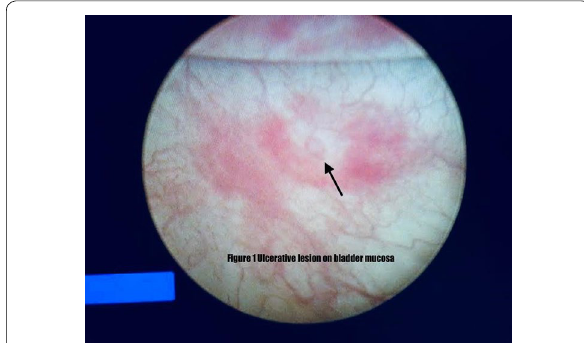
Fig. 1 Cystoscopy image showing an ulcerative lesion surrounded by areas of inflammation of the mucosa